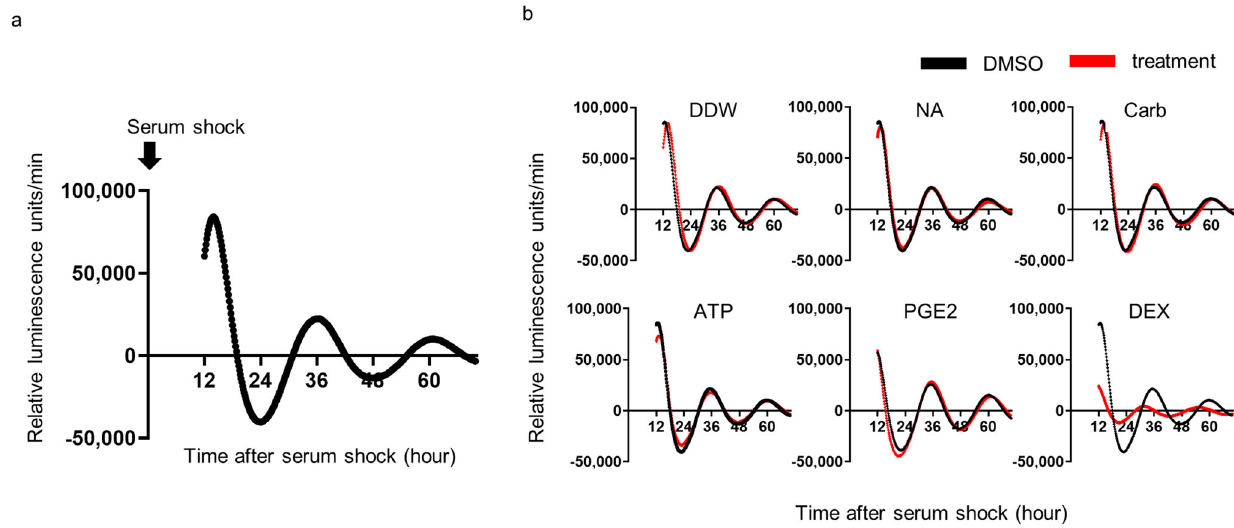
Fig. 1 TRT-HU1 Bmal1 -Luciferase cell luminescence and effect of reagents. a schematic diagram of the mean quanti fi ed Bmal1 -Luciferase ( Bmal1 -Luc) relative luminescence intensities in 35 mm dishes after serum shock. b Successive changes of relative luminescence intensities of Bmal1 -Luc cells by adding DDW, NA 10 μ M, Carb 10 μ M, ATP 10 μ M, PGE2 10 μ M, and DEX 0.1 μ M to the medium, compared with 0.2% DMSO. One representative of two experiments with similar results is shown (DDW: distilled water, NA: noradrenaline, Carb: carbachol, ATP: adenosine triphosphate, PGE2: prostaglandin E2,